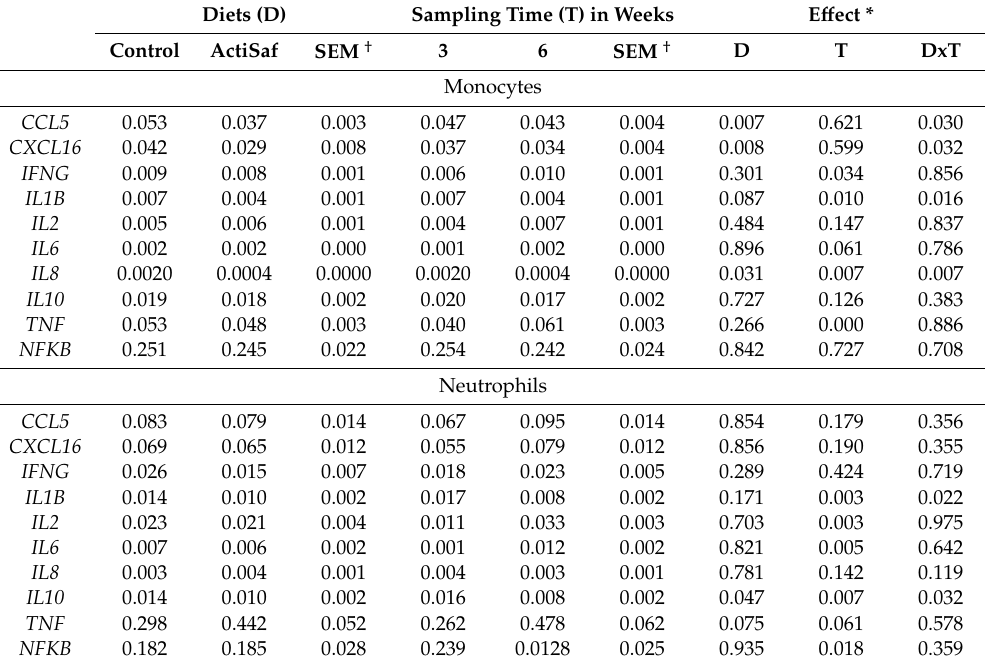
Significance level below 0.05 indicates significant di ff erence. † SEM = Standard error of the mean. CCL5 : C-X-C motif chemokine 5. CXCL16 : C-X-C motif chemokine ligand 16. INFG : Interferon γ . IL1B : Interleukin-1 beta. IL2 : Interleukin-2. IL6: Interleukin-6. IL8 : Interleukin-8. IL10 : Interleukin-10. TNF : Tumor Necrosis Factor. NFKB : Nuclear Factor kappa B. * E ff ect: The dietary treatment (D), time (T), and the interaction between dietary treatment × time (DxT) e ff ects were analyzed by ANOVA using a general linear model (GLM) for repeated measures and posthoc analysis was performed when appropriate using Tukey’s multiple range test.